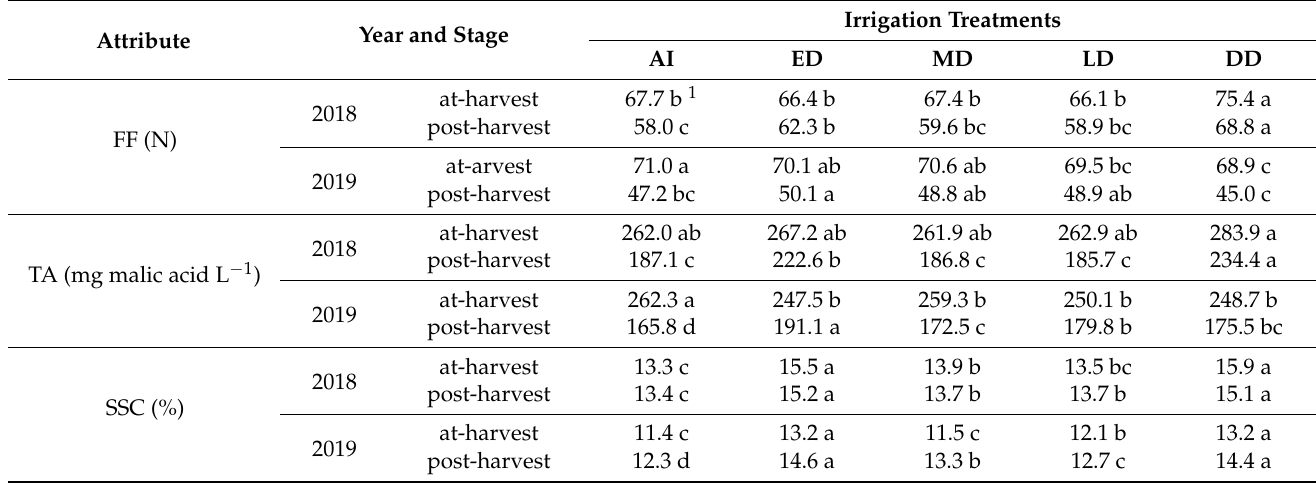
Table 3. Changes of the compositional quality attributes of Ambrosia TM apples between the at- and post-harvest measurements in the years 2018 and 2019.